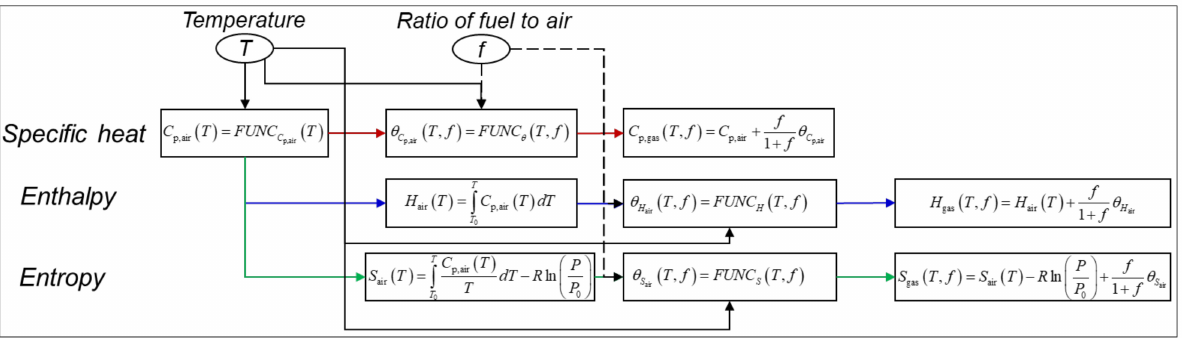
Figure 5. The properties of air and gas considering the variable specific heat